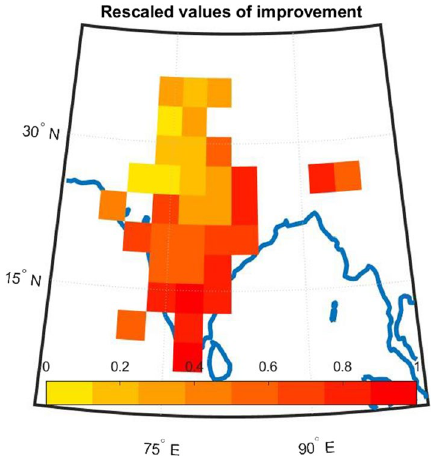
Fig. 11 Cumulative rescaled values of improvement percentage between 0 and 1 with masking of study locations falling in the ‘poor’ choice category with respect to environmental